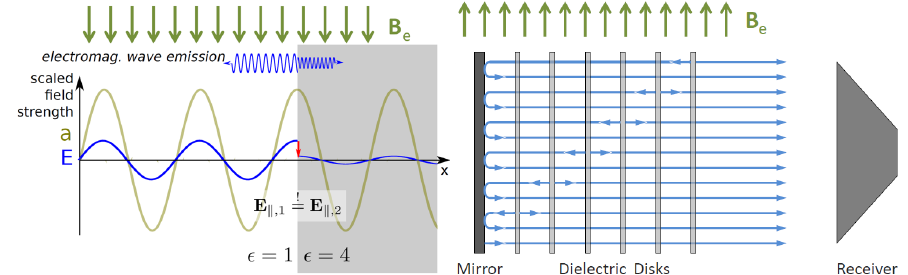
Figure 1. Left: Visualization of photon emission from surfaces with change of dielectric constant. Right: Sketch of the principle of a dielectric haloscope. For details see